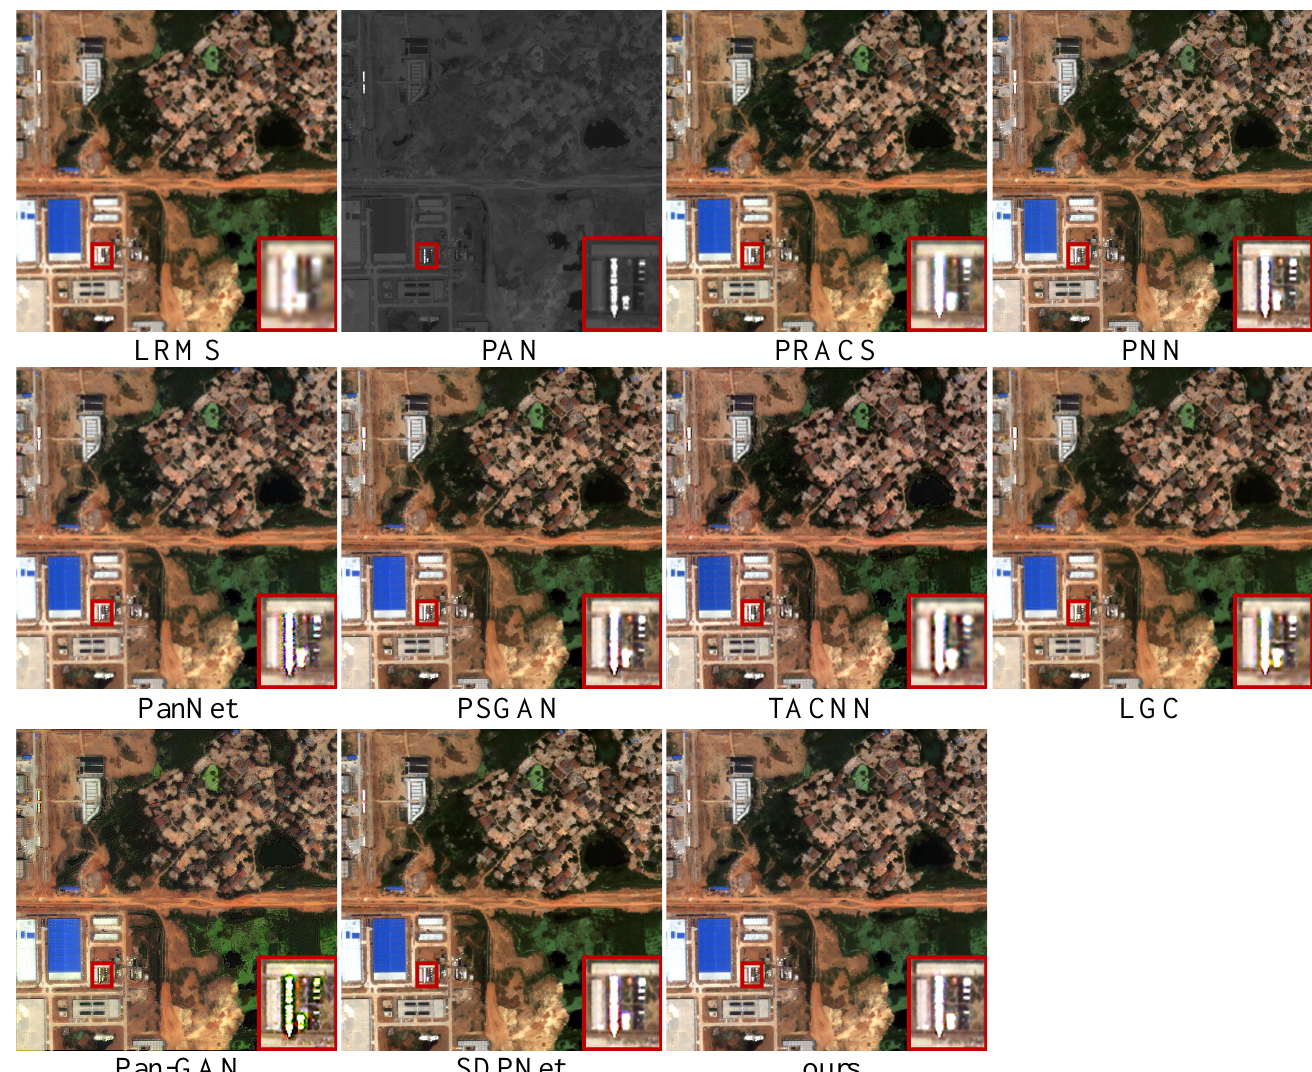
Figure 10. Qualitative comparison of CPNet with other eight pan-sharpening methods on the data from the QuickBird data set in full-resolution validation. The PAN images are of size 1056 × 1056, and the LRMS images are of size 264 × 264 × 4. The generated HRMS images are of size 1056 × 1056 ×